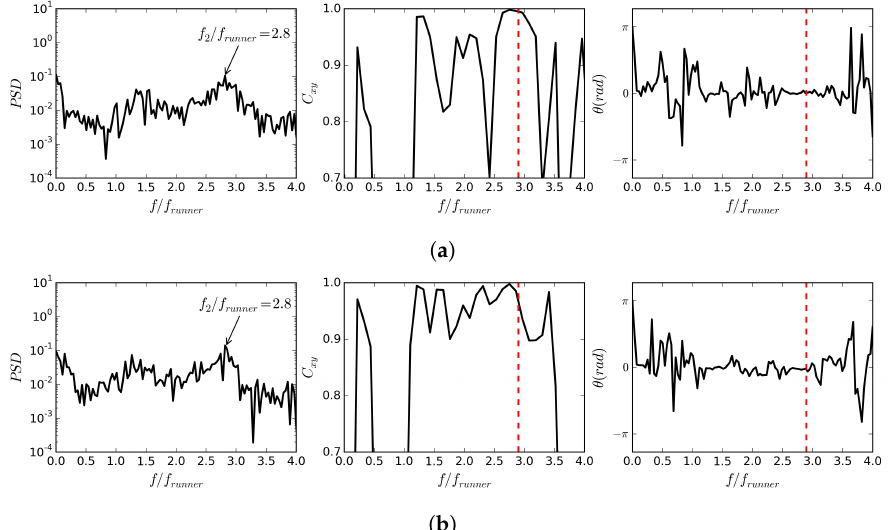
Figure 8. Spectral analysis of pressure signal from Probes 2 and 3 in the draft tube in the experiment at ( a ) Best Efficiency Point (BEP), and ( b ) High Load (HL), frequency analysis of pressure signal from Probe 2 (left plot), the coherence (middle plot) and the phase difference (right plot) between the pressure signals from Probes 2 and 3 in the